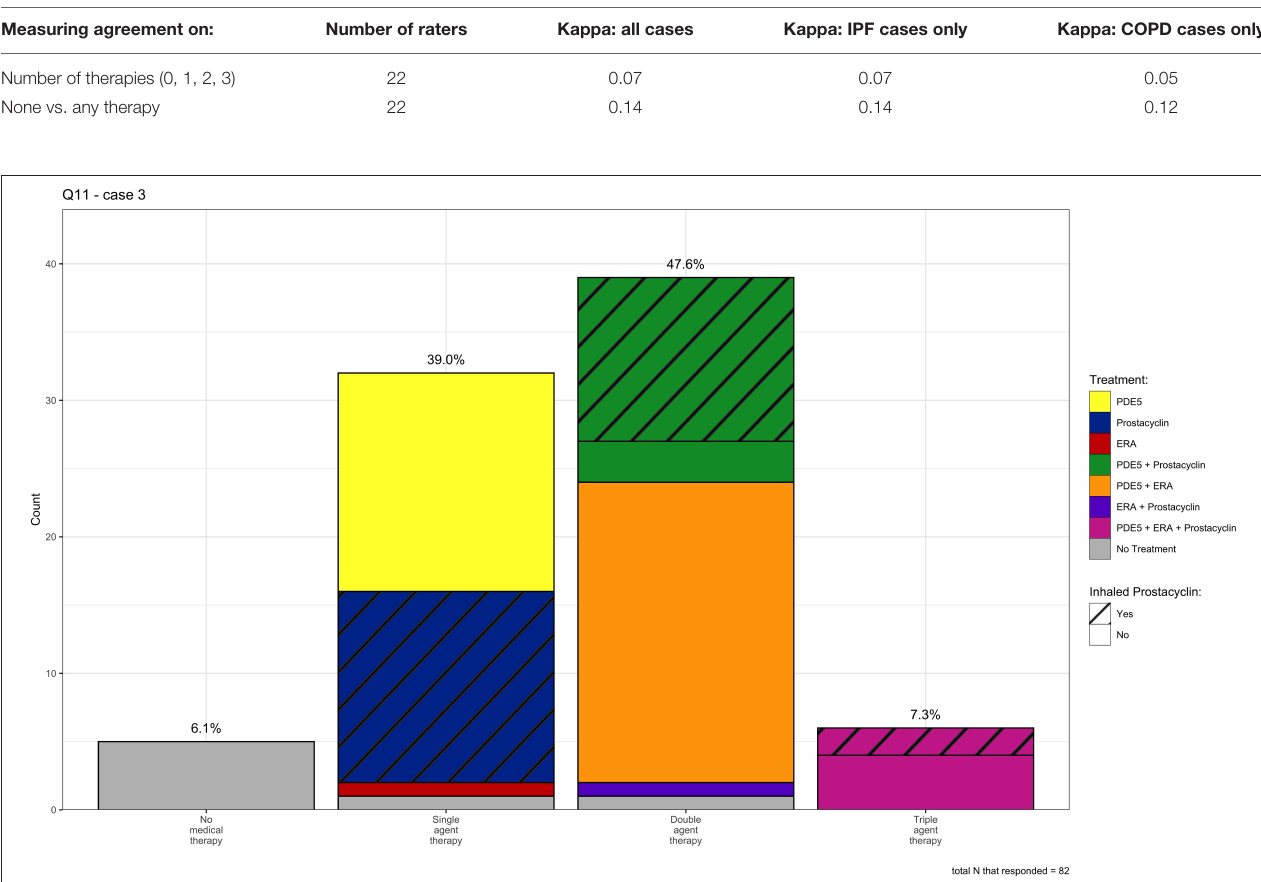
Frontiers in Medicine |